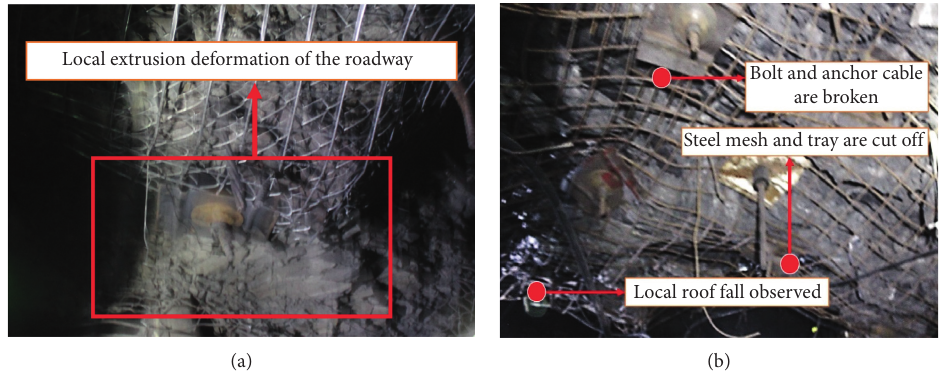
Figure 2: Actual deformation of the haulage roadway.